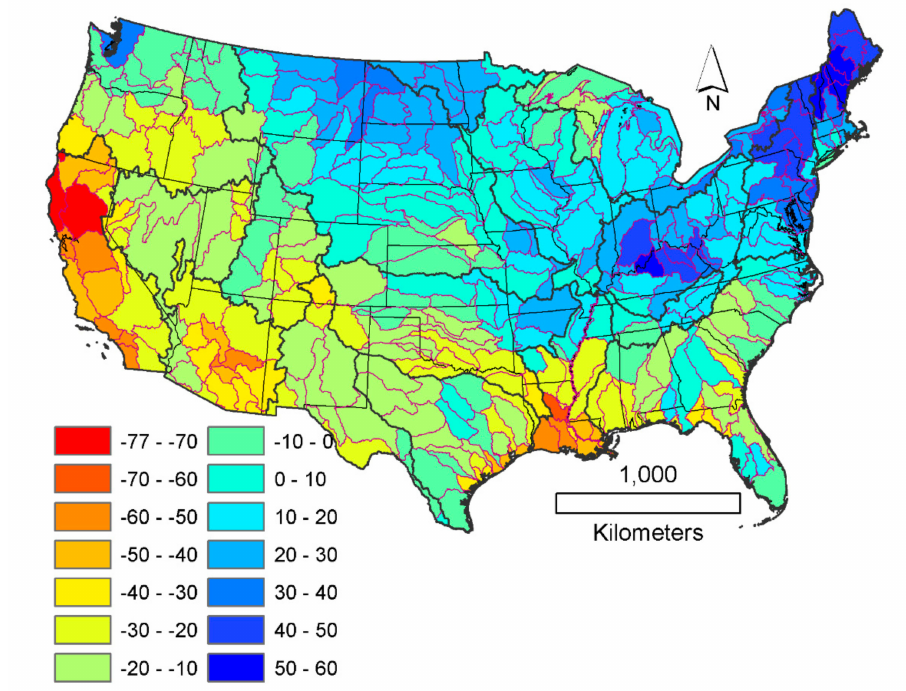
Figure 12. Spatial distribution of the linear tendencies (mm dec − 1 ) in the HUC6 annual PRISM precipitation rates (1979–2015). The seven HUC6 basins with outlier streamflow rates (Figure 1) are left in the map for spatial